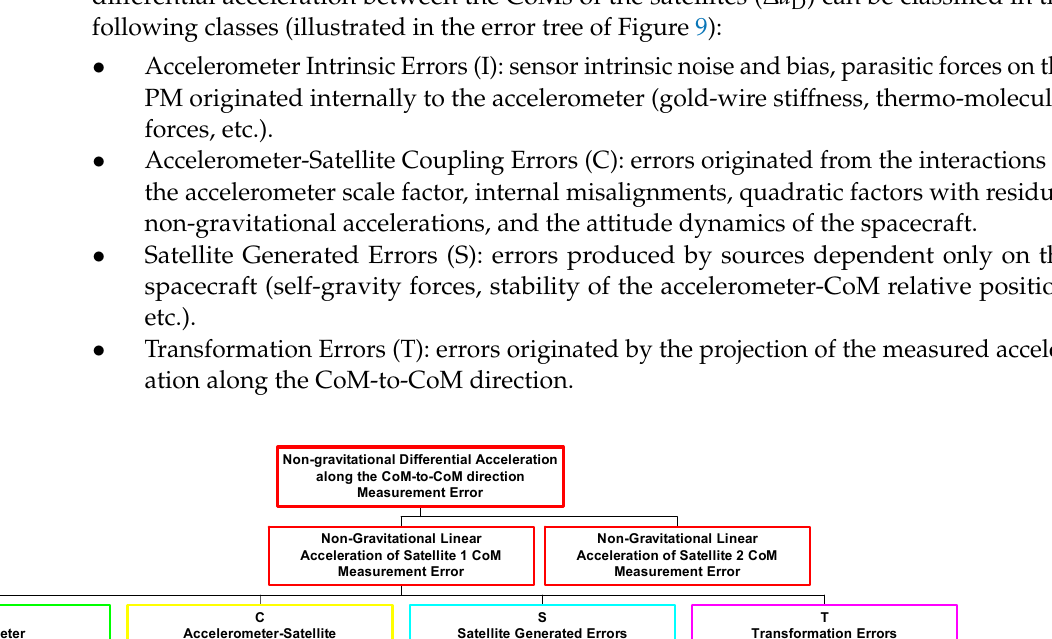
Figure 8. Accelerometer reference frame (X A , Y A , Z A ) to SSRF (X SS , Y SS , Z SS ) misalignment giving rise to the pitch/yaw-dependent error term δ a D .